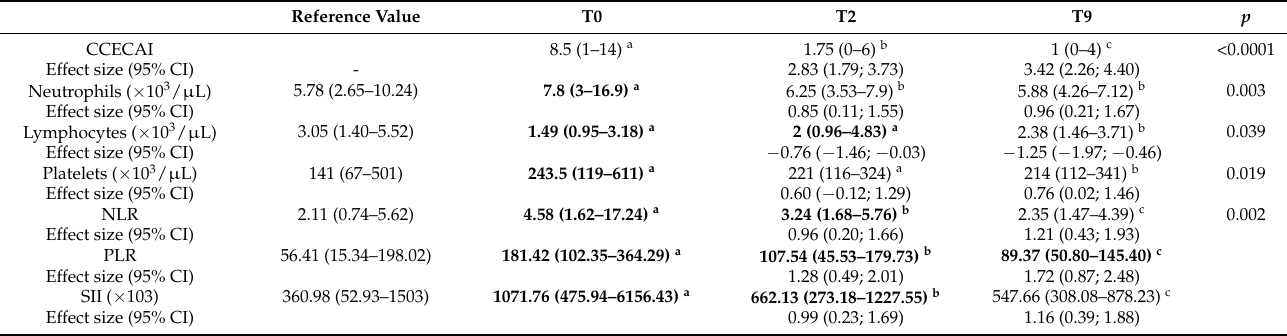
Table 1. Descriptive statistics of the studied